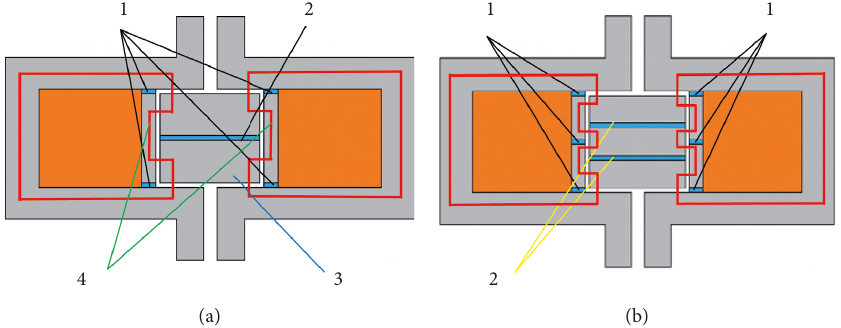
Figure 41: Schematic view of MR valve with serpentine-flux path. (a) One-step serpentine-flux valve. (b) Two-steps serpentine-flux valve.1, nonmagnetic rings; 2, nonmagnetic disks; 3, core; 4, coil separator [80].